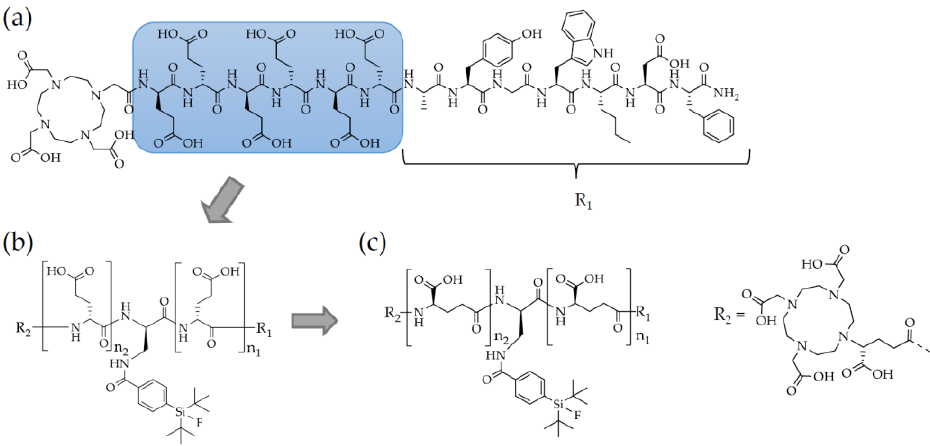
Figure 1. Structure of ( a ) DOTA-PP-F11N. ( b ) Structure of the rhCCK derivatives (( R )-DOTAGA- rhCCK-1-9) comprising a modified linker section generated via the introduction of a dap(SiFA) moi- ety into the D-glutamate chain (( R )-DOTAGA-rhCCK-1-7: n 1 = 0 to 6 and n 2 = 6 − n 1 ; ( R )-DOTAGA- rhCCK-8: n 1 = 7 and n 2 = 0; ( R )-DOTAGA-rhCCK-9: n 1 = 8 and n 2 = 0) of DOTA-PP-F11N. ( c ) Structure of the rhCCK derivatives (( R )-DOTAGA-rhCCK-10-18) generated analogous to B but containing a γ -instead of an α -linked D-glutamate chain (( R )-DOTAGA-rhCCK-10-16: n 1 = 0 to 6 and n 2 = 6 − n 1 ; ( R )-DOTAGA-rhCCK-17: n 1 = 7 and n 2 = 0; ( R )-DOTAGA-rhCCK-18: n 1 = 8 and n 2 = 0).